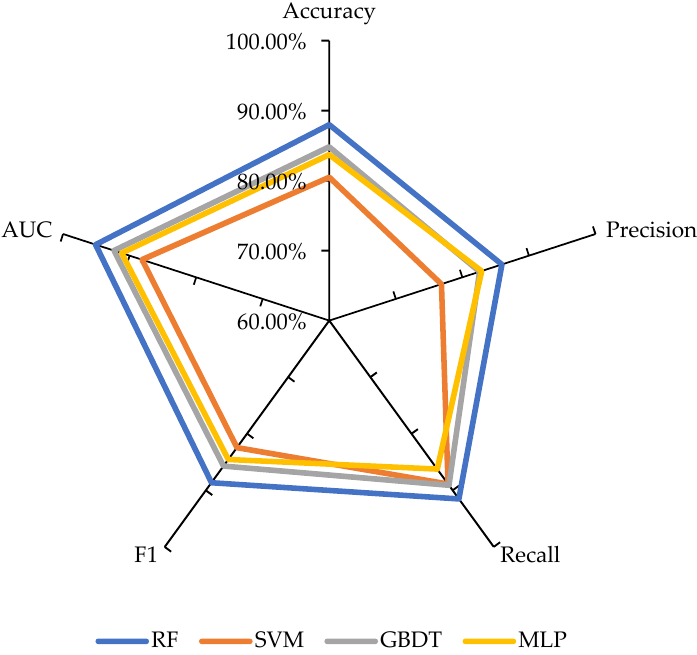
Figure 3. Comparison of the precision levels of the four machine learning (ML) models.